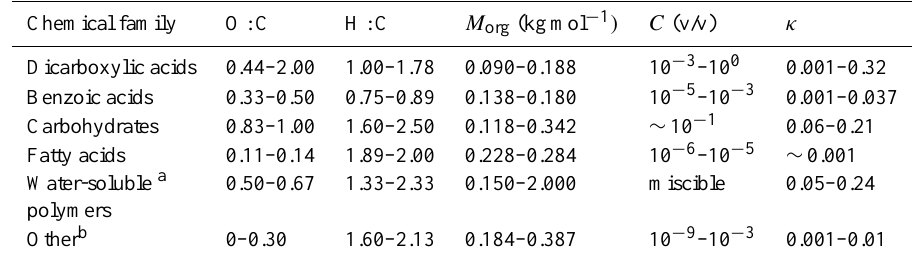
Table 5. Summary of compounds employed for Fig. 3. The complete list is available in the Supplement. Chemical family O:C H:C M org (kgmol − 1 ) C